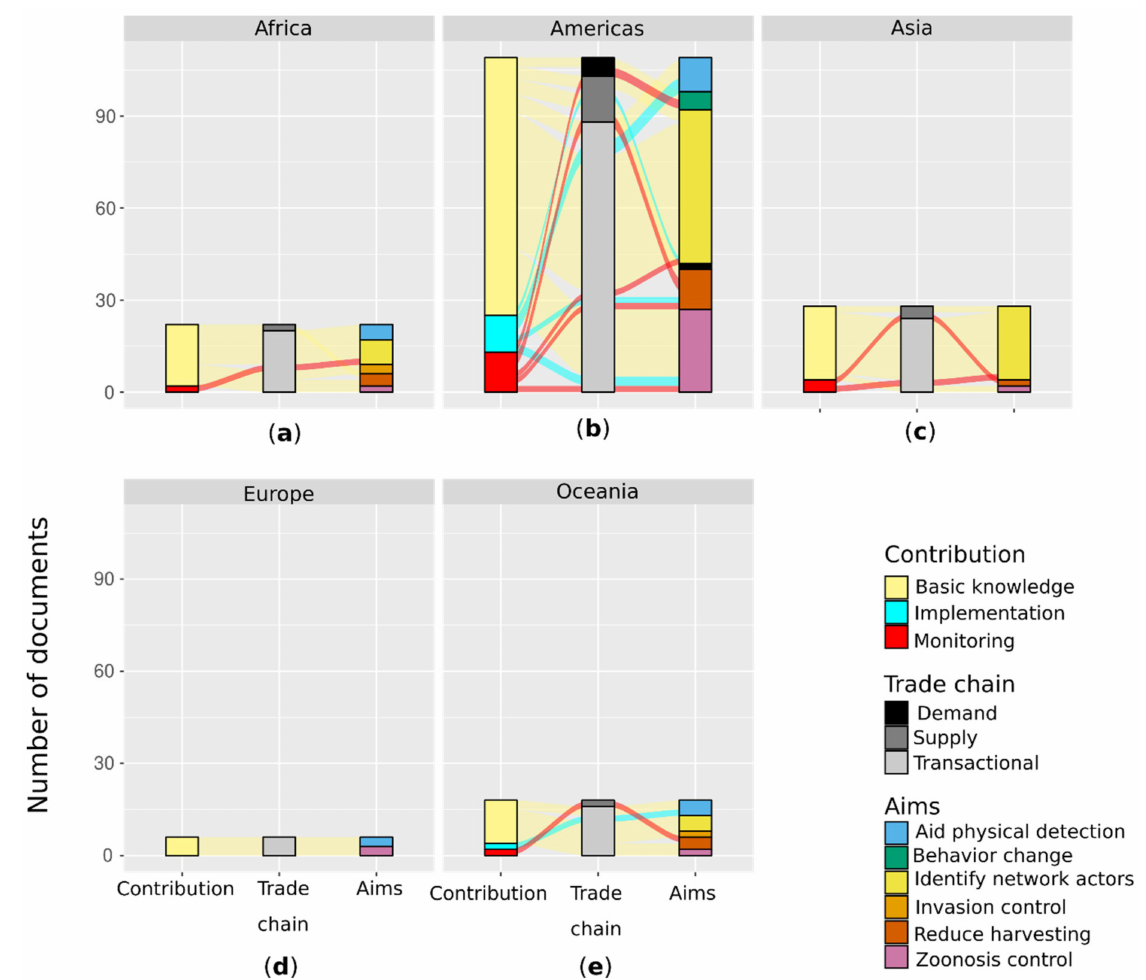
Figure 5. Trends in the illegal parrot trade literature in ( a ) Africa, ( b ) Americas, ( c ) Asia, ( d ) Europe, and ( e ) Oceania, showing the combination of research contribution, trade chain focus, and action aims. Each column represents the variables analyzed about research contribution, trade chain, and actions. Column length is proportional to the number of documents classified under each variable category. Flows across columns are proportional to the frequencies of variable combinations. Color flow traces the research contribution level of basic knowledge (beige), action implementation (cyan), and monitoring